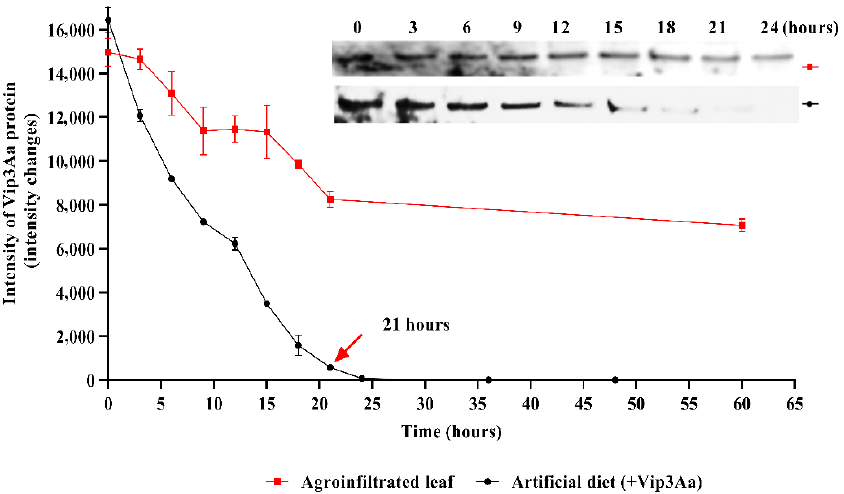
Figure 4. The stability of Vip3Aa in the recombinant protein-treated artificial diet and infiltrated plant leaves. The stability of the Vip3Aa protein in the recombinant Vip3Aa-treated artificial diet (100 ng/mg) and third-day plant leaves after Vip3Aa-agroinfiltration. Each sample was collected per 3 h, and the protein expression level was quantified by immunoblot analysis with anti-Vip3Aa Ab. Protein intensity was measured using the ImageJ (version 1.53n) program. The red arrow indicates the last indication time point of Vip3Aa protein, and inset data shows the western blot assay data until 24 h. All values represent the mean ± standard deviation (SD) of triplicate experiments.